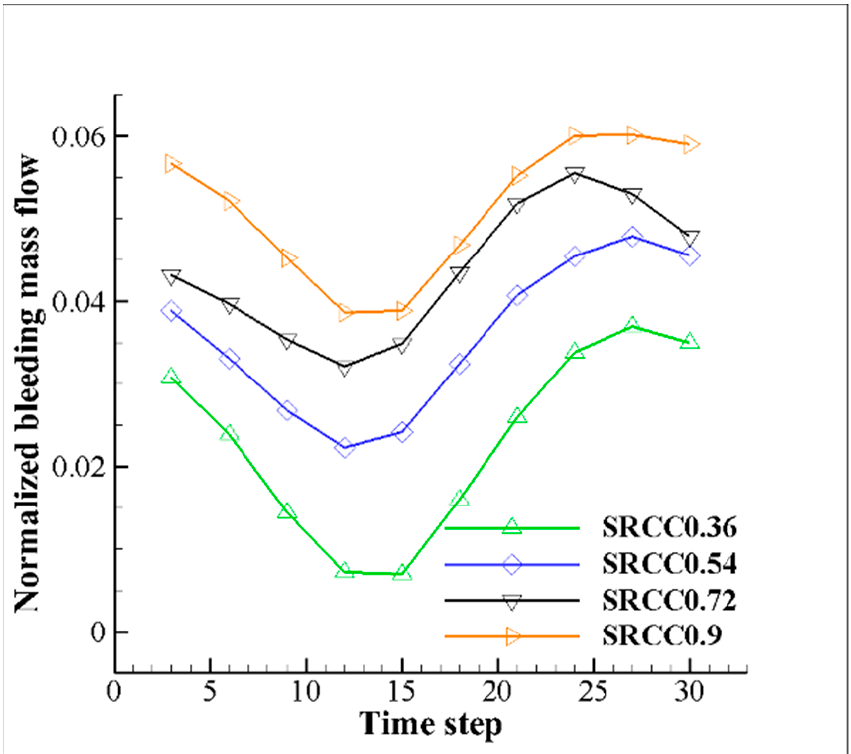
Figure 25. Change in dimensionless mass flow rate under the different self-circulating casings over time.